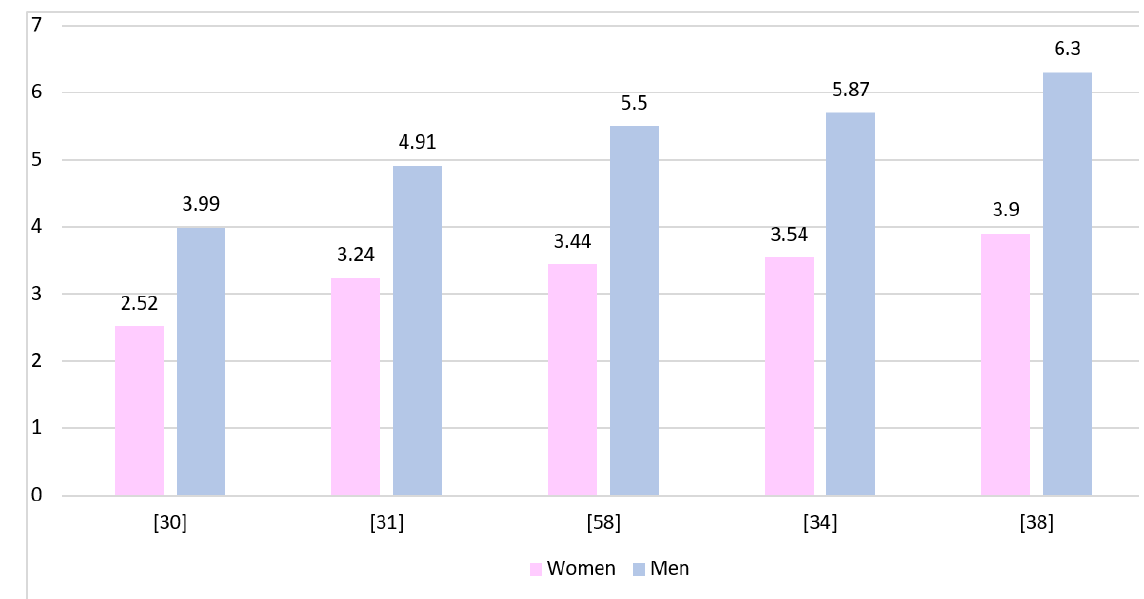
Figure 2. The incidence rates of GBM presented for both genders and calculated per 100,000 inhabitants of each population. In order to simplify data analysis, we used the male-to-female sex ratio in the popu- lations presented in the literature. Epidemiological reports describing the occurrence of GBM clearly indicate a higher incidence of this histological type in men (Table 1). The ratio ranged from 1.2 to 2.6 for studies conducted on adult populations, 1.34–2.5 for general populations, and 1–1.5 for children. The increased incidence of GMB in men is associated with differences in the activity of retinoblastoma protein and functioning of cancer stem cells [46]. Table 1. Male-to-female sex ratio in studies on GBM.